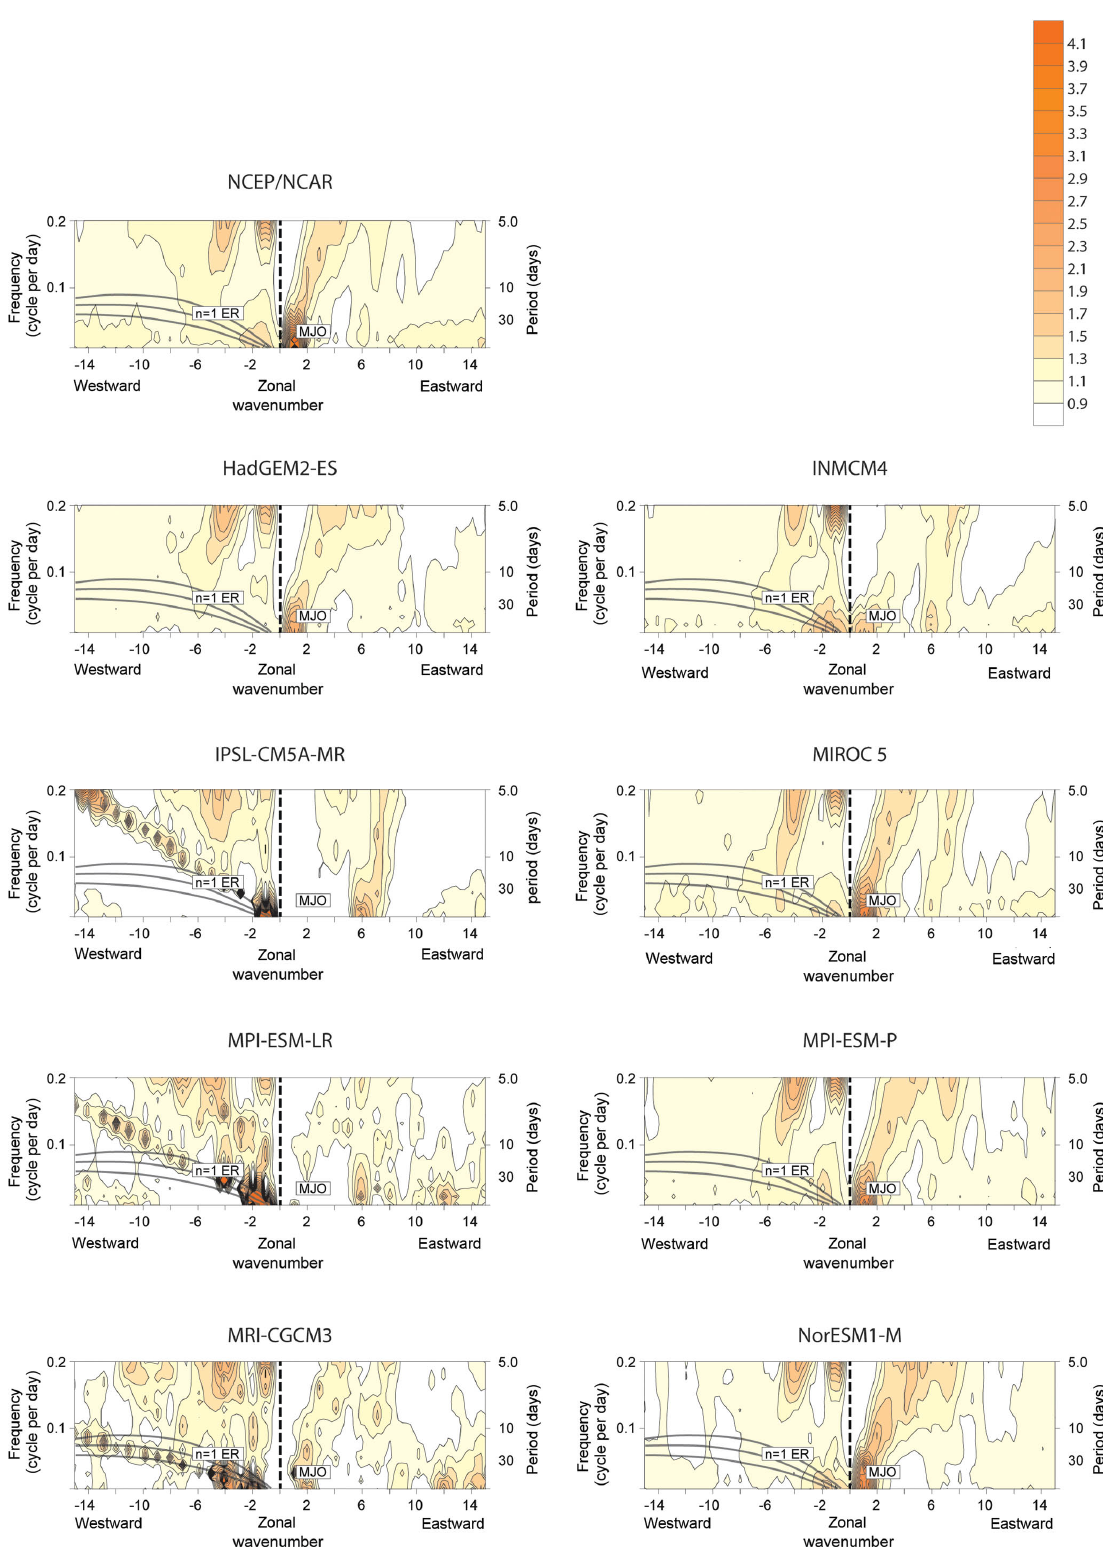
Figure 2. Space–time spectrum averaged between 15 ◦ N and 15 ◦ S of the symmetric component of U850 divided by the background spectrum for the NCEP/NCAR Reanalysis and the CMIP5